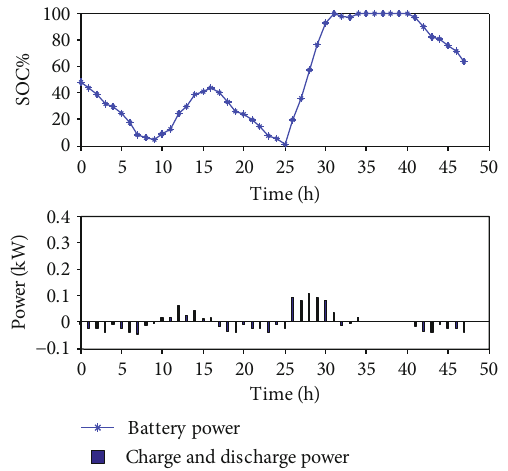
Figure 9: Battery charge state and 48h charge and discharge power (without algorithm).